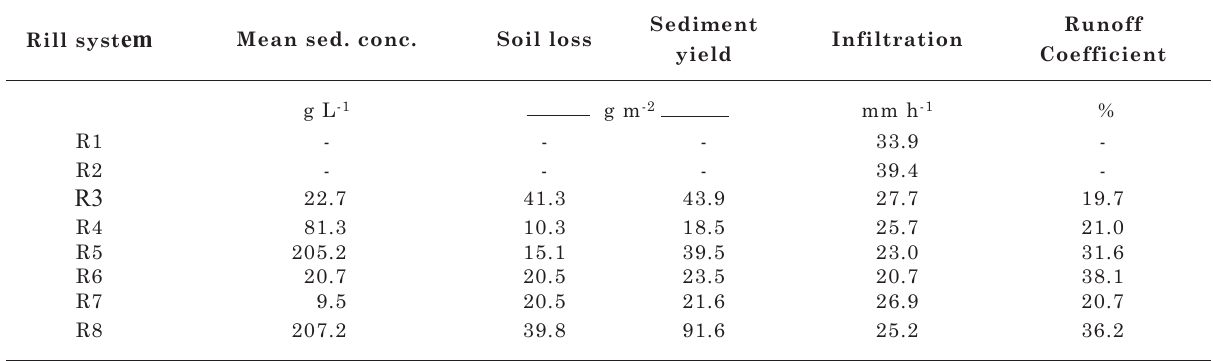
table 3. Summary of sediment production and hydrological response in the rill systems